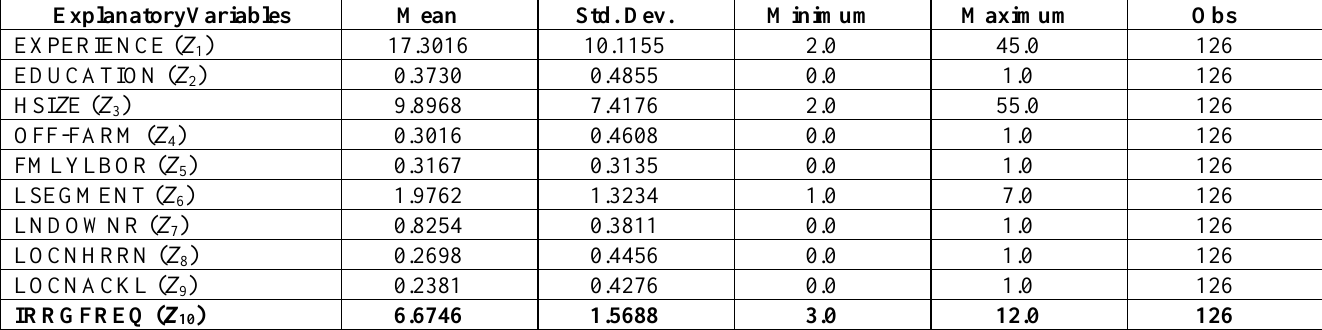
Table 4: Explanatory variables' descriptive statistics used to assess the inefficiency effects model.